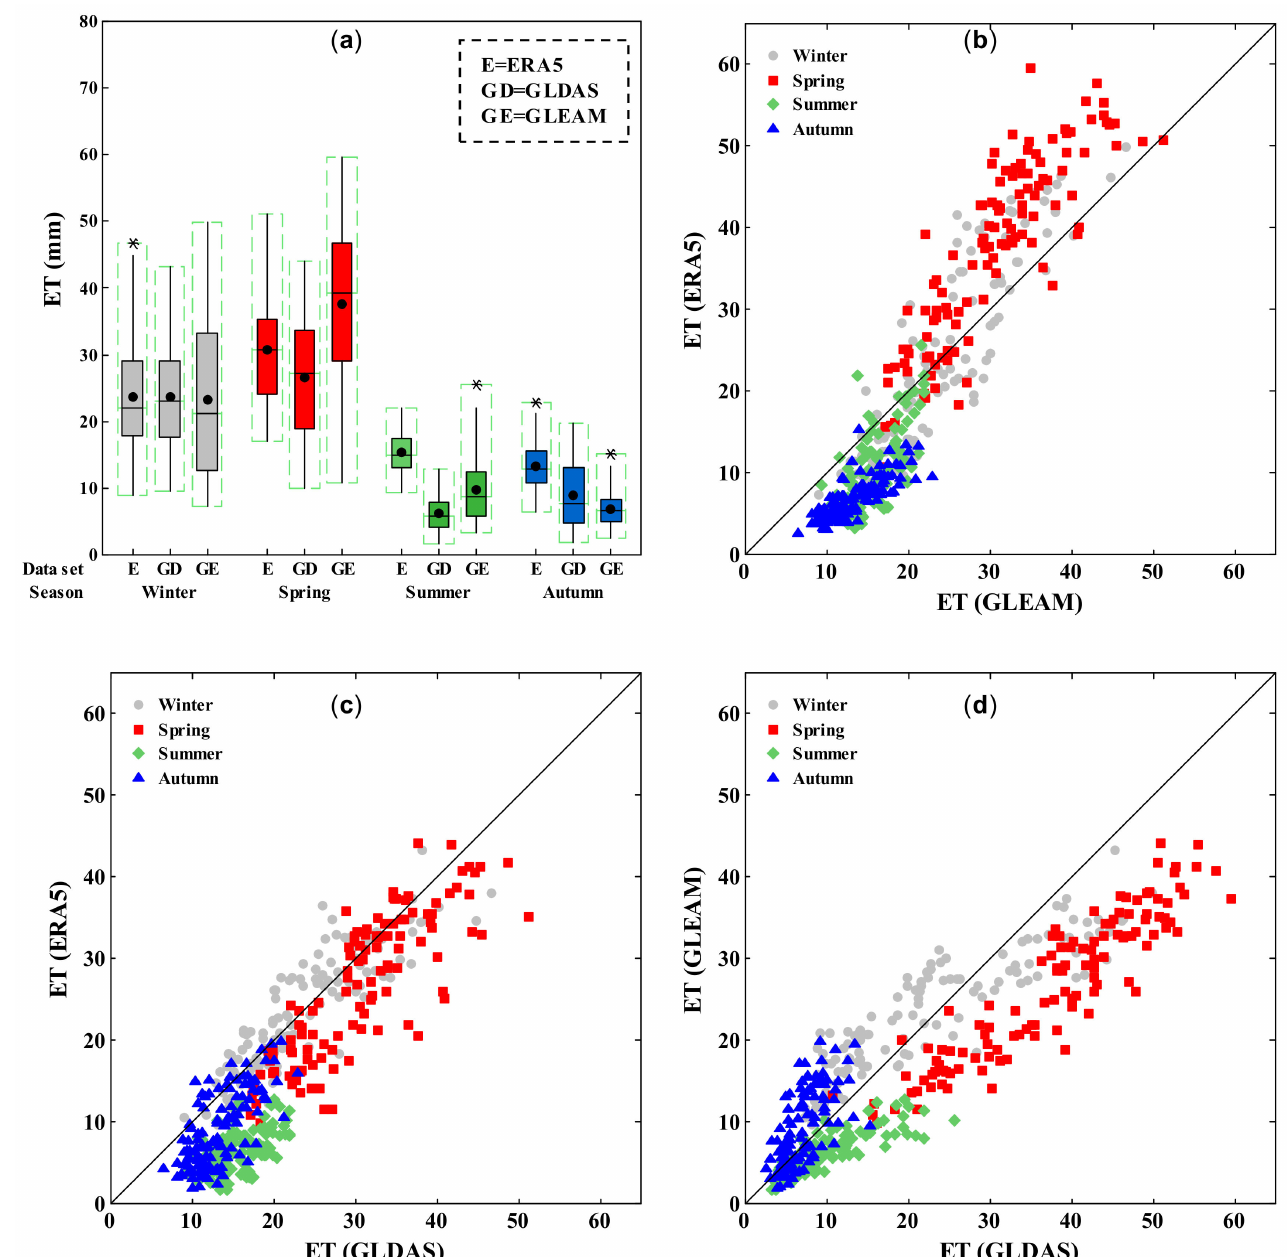
Figure 4. Seasonal comparison of ET GLEAM , ET ERA5 , and ET GLDAS in Iran between 1980 and 2018. ( a ) Box plot of seasonal ET values based on ERA5, GLDAS, GLEAM datasets, including average (black point), median (black line), standard deviation (black box), and range of values (green dashed box), and average seasonal differences between ( b ) ET GLEAM and ET ERA5 , ( c ) ET GLEAM and ET GLDAS , and ( d ) ET ERA5 and ET GLDAS